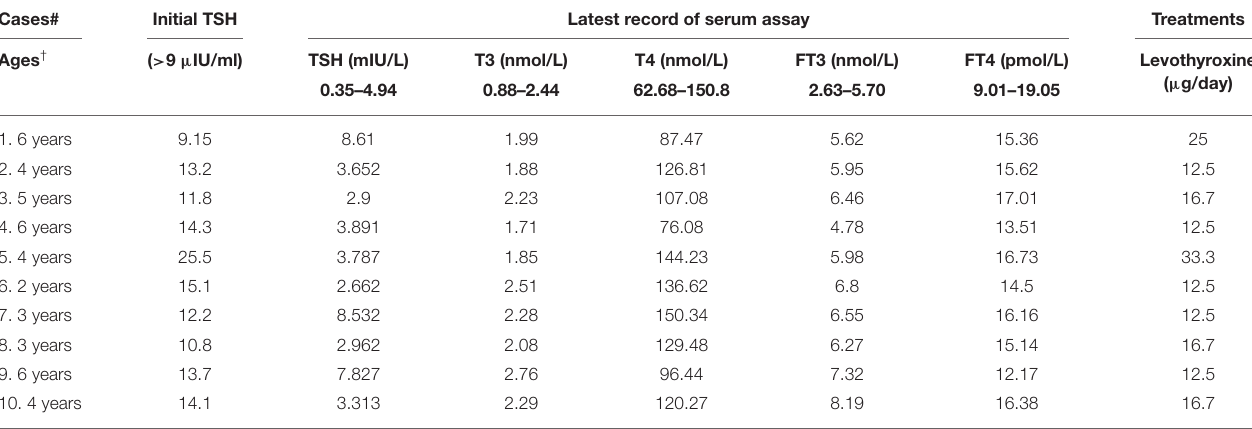
TABLE 1 | The clinical data of 10 primary congenital hypothyroidism